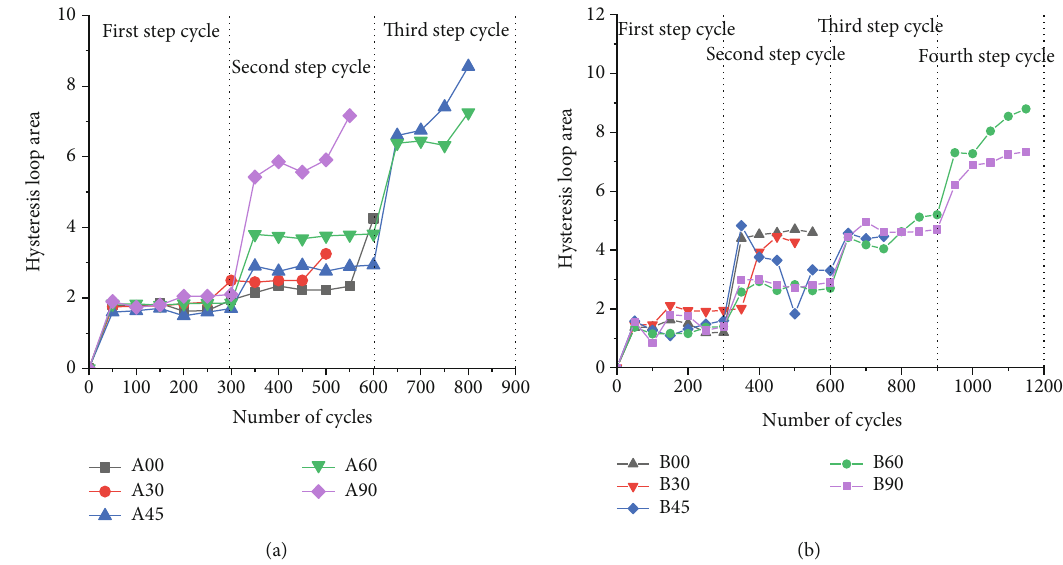
Figure 12: Hysteresis loop area curves for group A and B